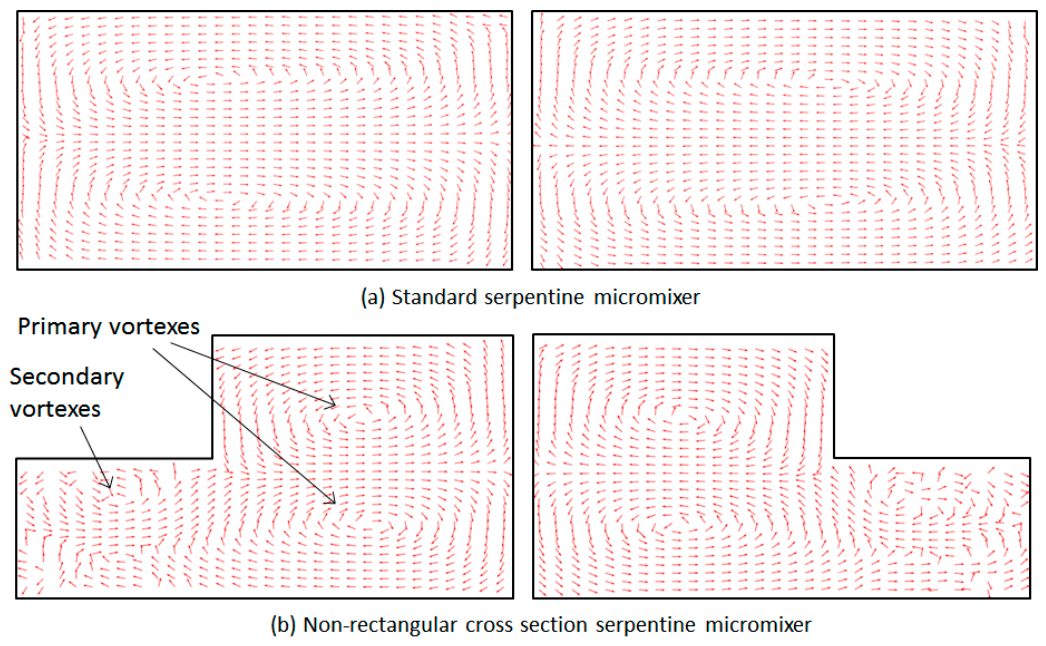
Figure 8. Arrow plots of the velocity field for the two mixers design: ( a ) a standard micromixer and ( b ) a non-rectangular cross-section micromixer. Both sets of data are collected for the 2nd mixing cycle at Re = 20. The left plots are for data collected at the midpoint of the first leg of the mixing cycle, while the right images are the corresponding plots for the second leg of the mixing cycle.